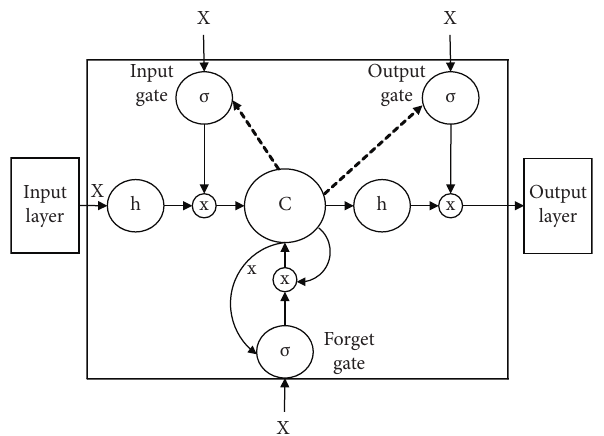
Figure 6: Architecture of the LSTM